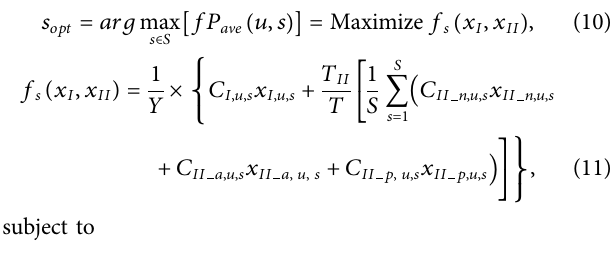
Frontiers in Environmental Science |